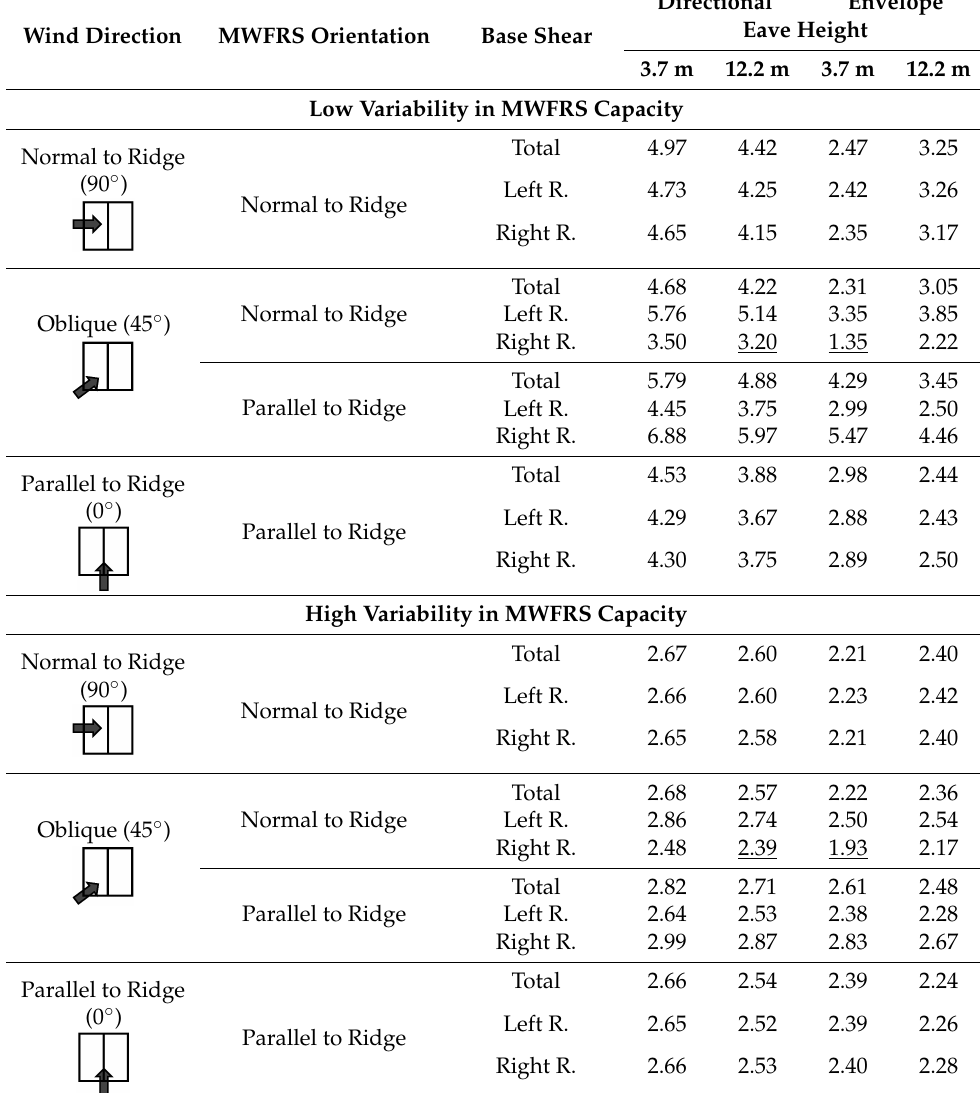
Table 4. Reliability index, β for MWFRS with a range of variability in capacity.